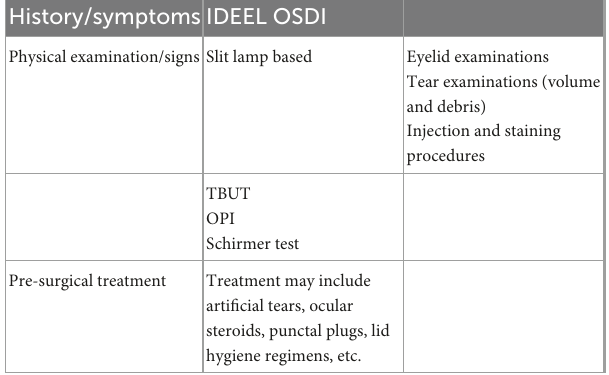
TABLE 2 Preoperative DED